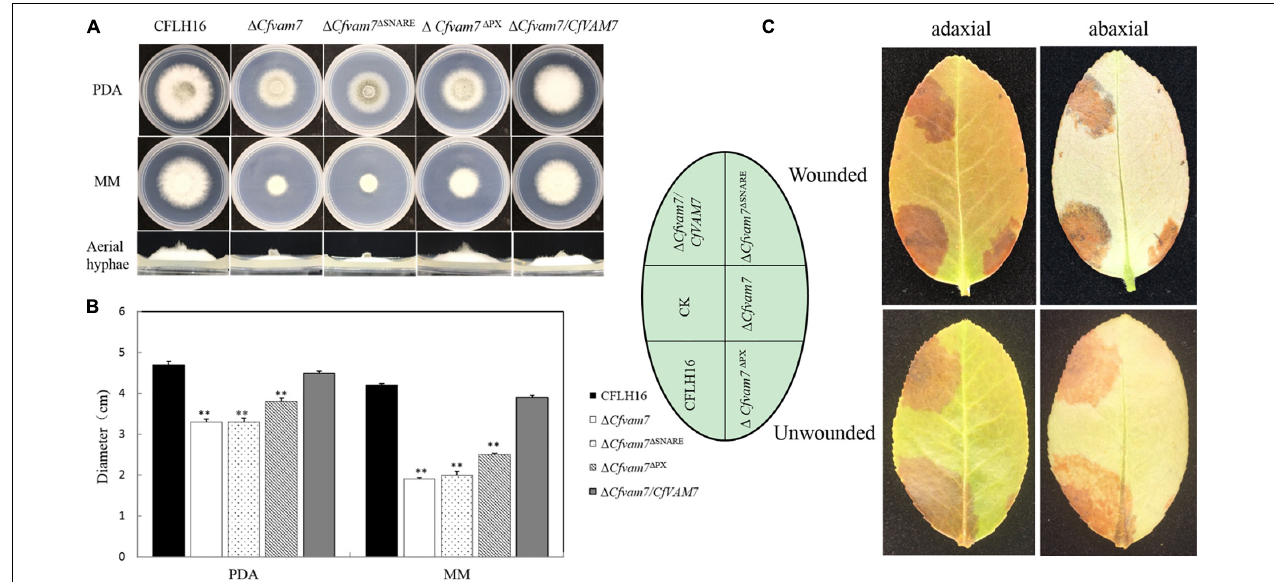
FIGURE 7 | The Phox homology (PX) and SNARE domain is important for the function of CfVam7. (A) Growth of wild type (WT), (cid:49) Cfvam7 , (cid:49) Cfvam7 (cid:49) SNARE , (cid:49) Cfvam7 (cid:49) PX , and (cid:49) Cfvam7 / CfVAM7 on potato dextrose agar (PDA) and MM plates. (B) Statistical analysis of colony diameters of the strains. Error bars represent SD of three replicates, and “**” indicate significant difference ( p < 0.01). (C) Diseased symptoms of wounded and unwounded tea-oil tree leaves inoculated with related mycelial plugs.